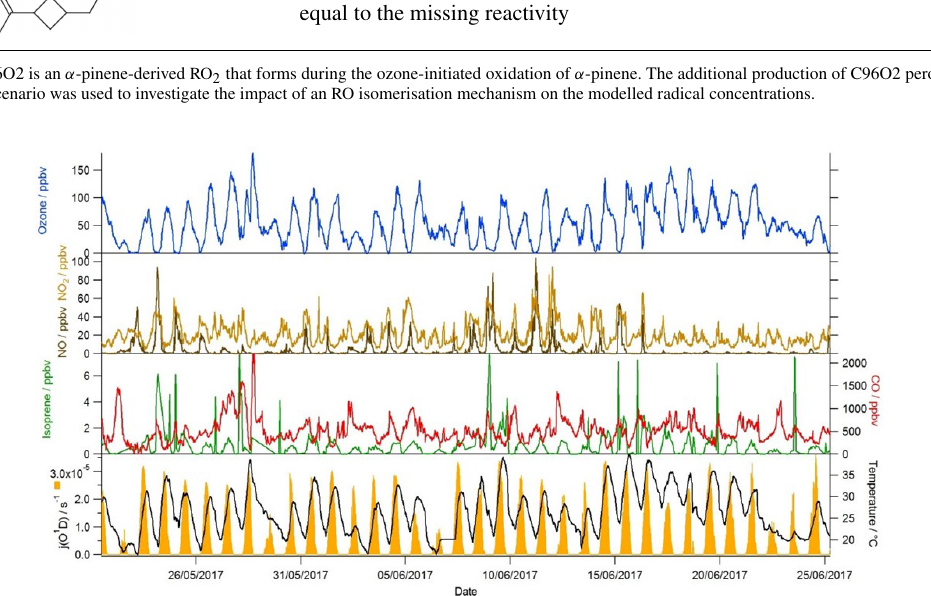
Figure 1. Time series of ozone, NO, NO 2 isoprene, CO, j( O 1 D ) and temperature during the